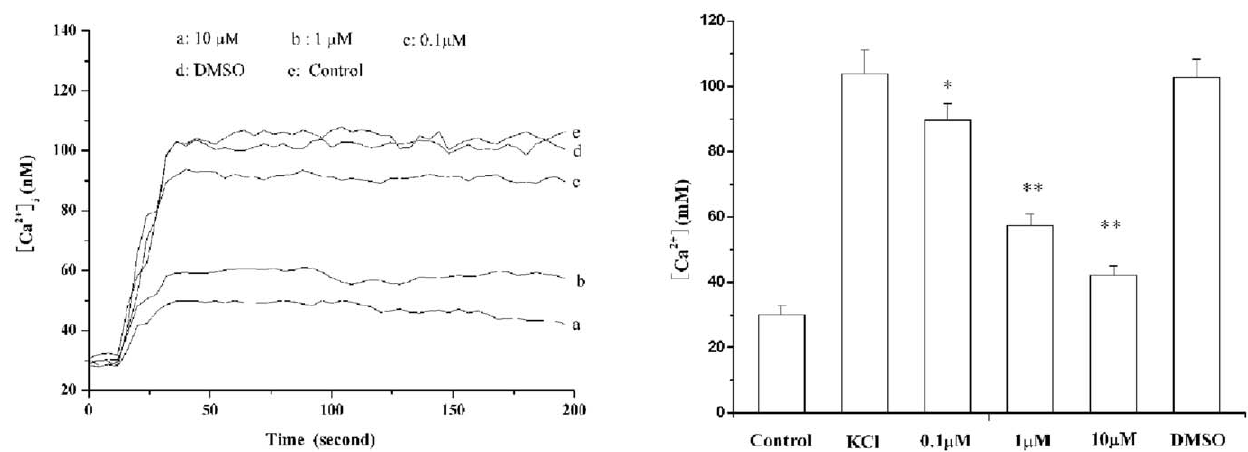
Figure 5. Effect of 16c (0.1 , 10 m M) and the vehicle (0.1% DMSO) on KCl (80 mM)-induced changes of Ca 2 + concentration in vascular smooth muscle cells. A, representative Ca 2 + concentration response to KCl ; B, dose-dependent inhibitory effect of 16c on the Ca 2 + concentration response to KCl. Results are the means 6 S.E. (n=24). *, p , 0.01 compared with normal. **, p , 0.01 compared with model (KCl).